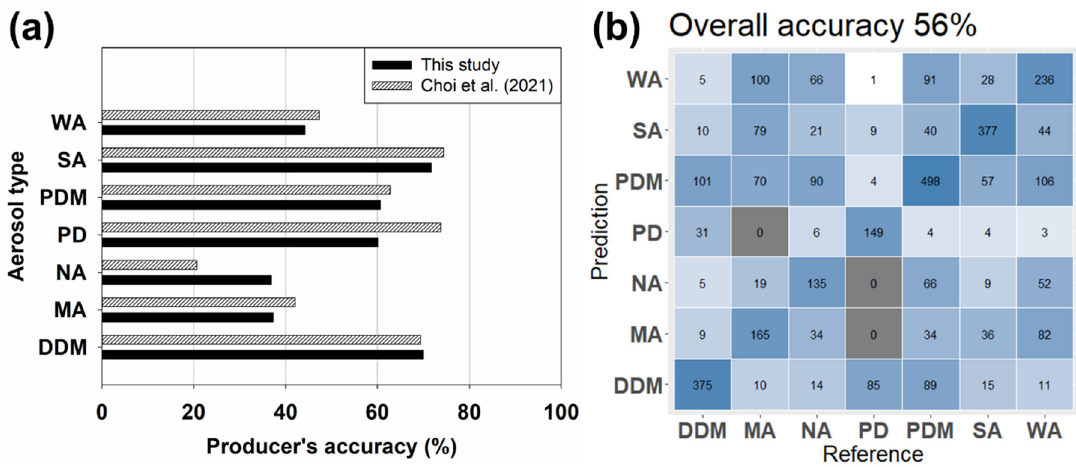
Figure 2. ( a ) producer’s accuracy (PA) and ( b ) confusion matrix for each aerosol with the classification of seven aerosol types (PD, DDM, PDM, SA, MA, WA, and NA).